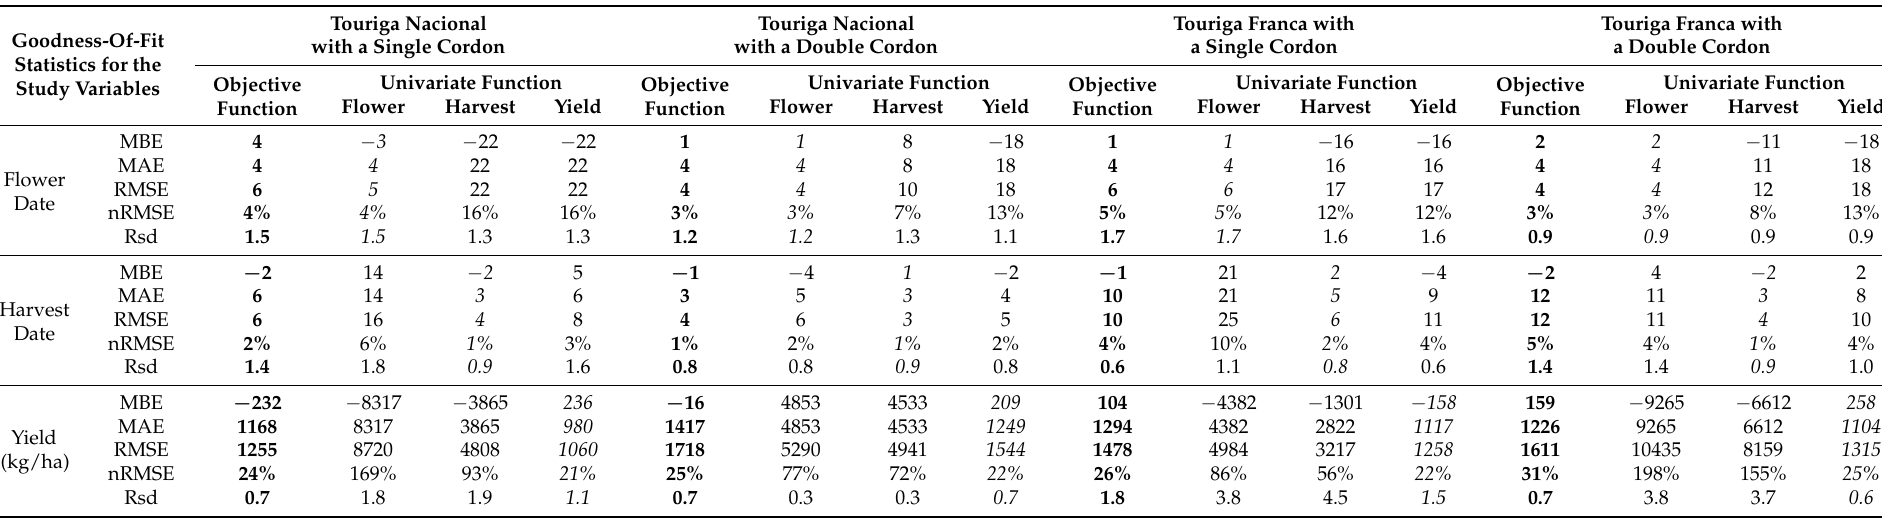
Table 4. Summary of various goodness-of-fit measures on the parameter combinations identified from the multivariate objective function, which is highlighted in bold, and from the univariate function that minimize the nRMSE for flowering date, harvest date and yield separately (highlighted in italic). MBE denotes Mean Biased Error; MAE denotes Mean Absolute Errors; RMSE denotes Root Mean Squared Errors; Rsd denotes the ratio of standard deviation of simulations to that of the observations. Goodness-Of-Fit Statistics for